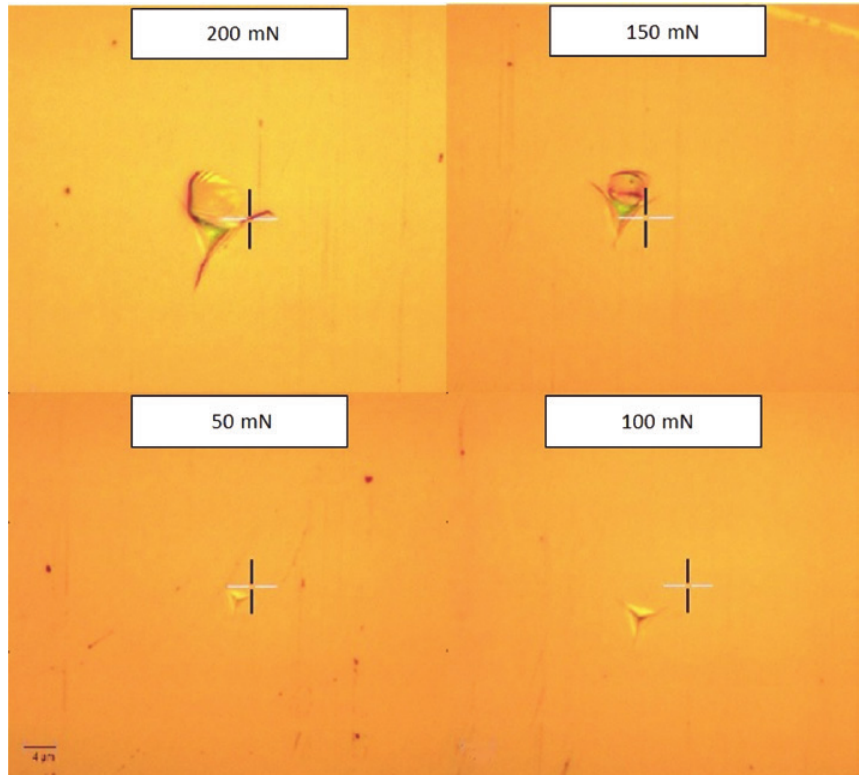
Figure 4: Optical images of the four indentation imprints on silicon wafers for maximum loads from 50 to 200